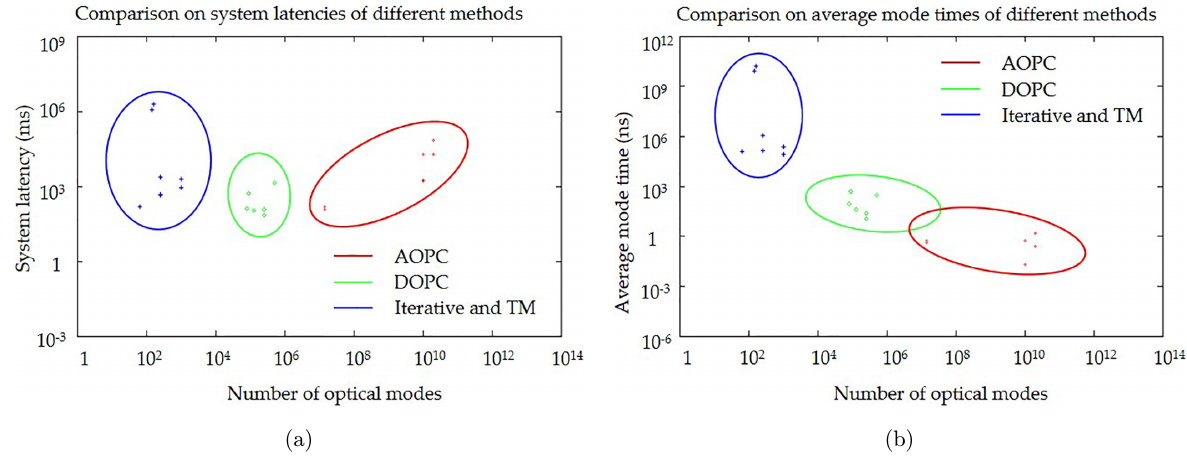
Fig. 4. Comparison on the speeds of various state-of-the-art WFE methods. (a) is system latency versus number of optical modes and (b) is average mode time versus number of optical modes. In (a) and (b), circles, diamonds and crosses represent various technical implementations of the AOPC, 33,36,38 – 41,45,47,94 DOPC, 49,53,57,61,62 and feedback-based iterative wavefront optimization and TM measurement, 67,69,72,73,78 – 81,95 respectively, and their ranges are represented by red, green and blue